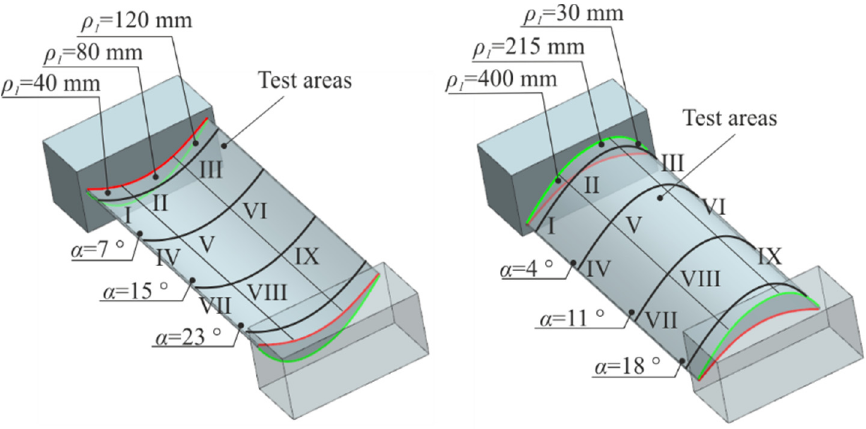
Figure 6. Test areas depending on the curvature radius ρ 1 and the lead angle α .